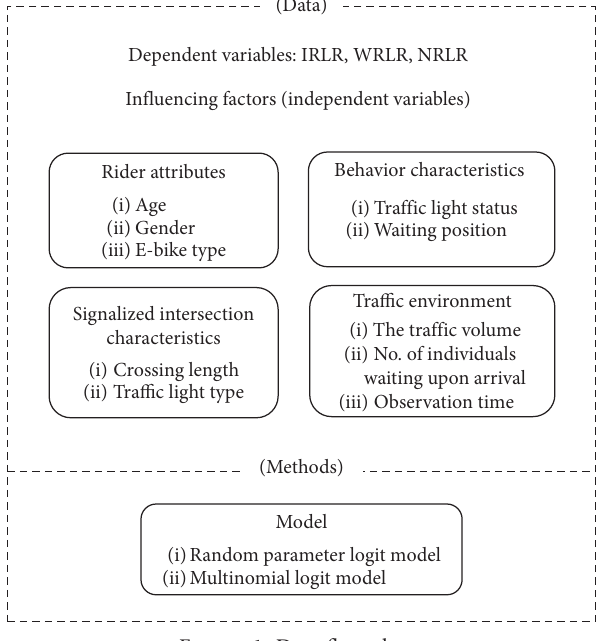
Figure 1: Data flow